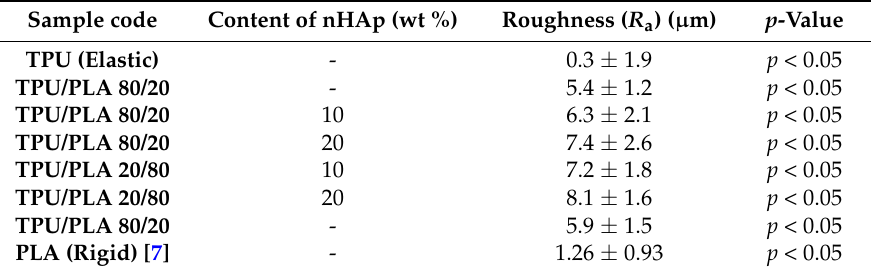
Table 5. The analysis of the experimental surface roughness determined in all composite materials and pure TPU and PLA films. p -values shows the statistical significance between the series ( p < 0.05).